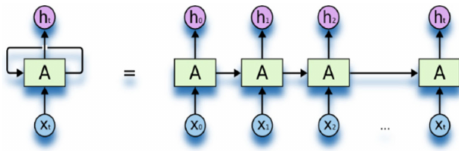
Figure A3. RNN Ref.